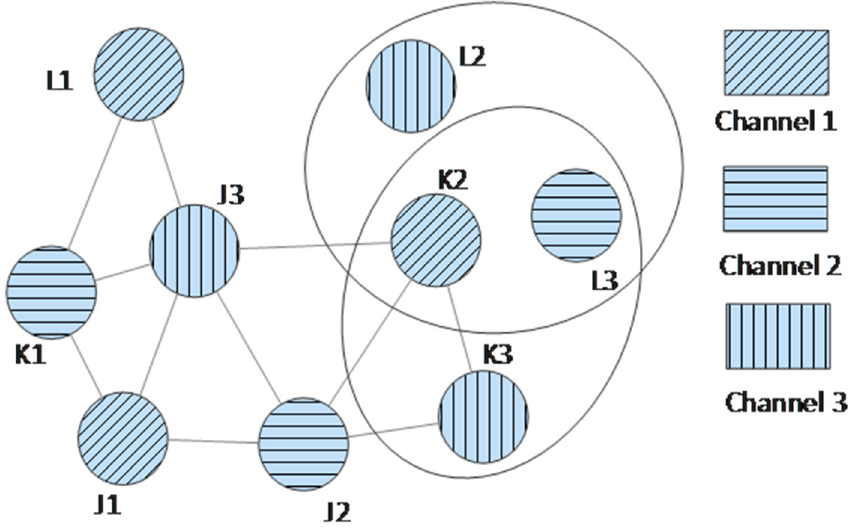
Figure 4. An example of hypergraph ‐ based matching and channel allocation. Table 4. Independent and cumulative interferer thresholds.